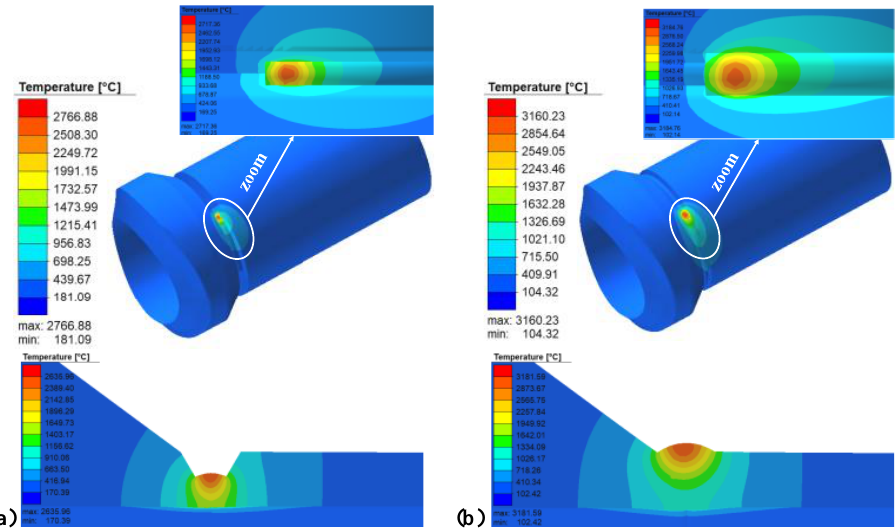
Figure 11. Numerically estimated thermal field: ( a ) first layer weld and its cross section, ( b ) second layer weld and its cross section.